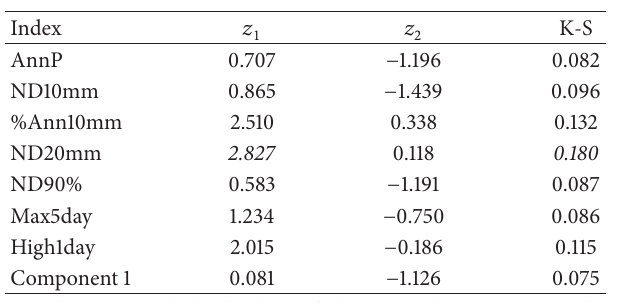
Table 1: Normality test results.